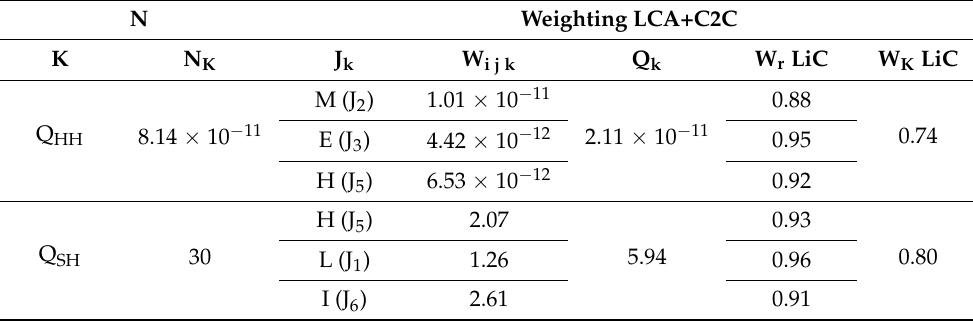
Table 5. Results of meso